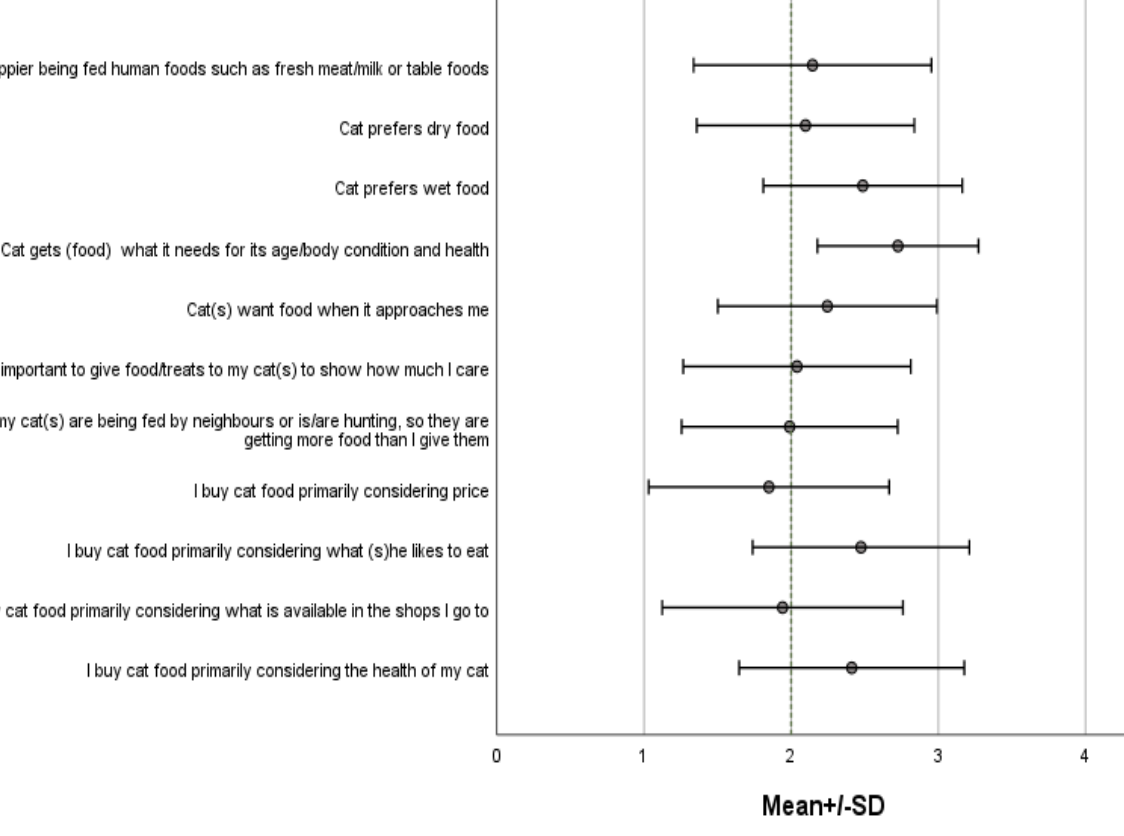
Figure 1. Owners attitude to cats dietary preferences, needs and the drivers of shopping for cat food. Response options ranged from 1 to 3 where 1 indicated ‘Not at all’, 2 indicated ‘Doubtfully’/‘Not sure’, 3 indicated ‘Very much so’.